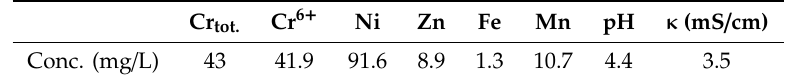
Table 1. Characteristic content of contaminants, pH, and conductivity of untreated water. Cr